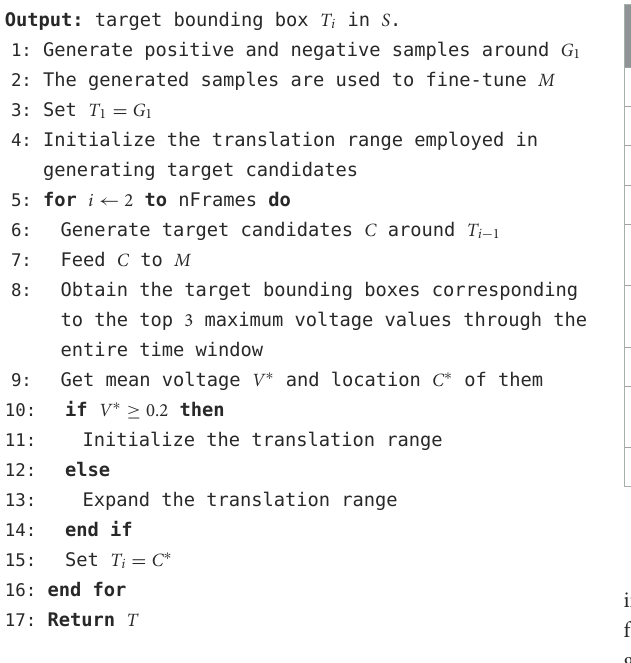
on a 64-core Intel Xeon Gold 5218 2.30GHz CPU and an NVIDIA 2080Ti GPU.